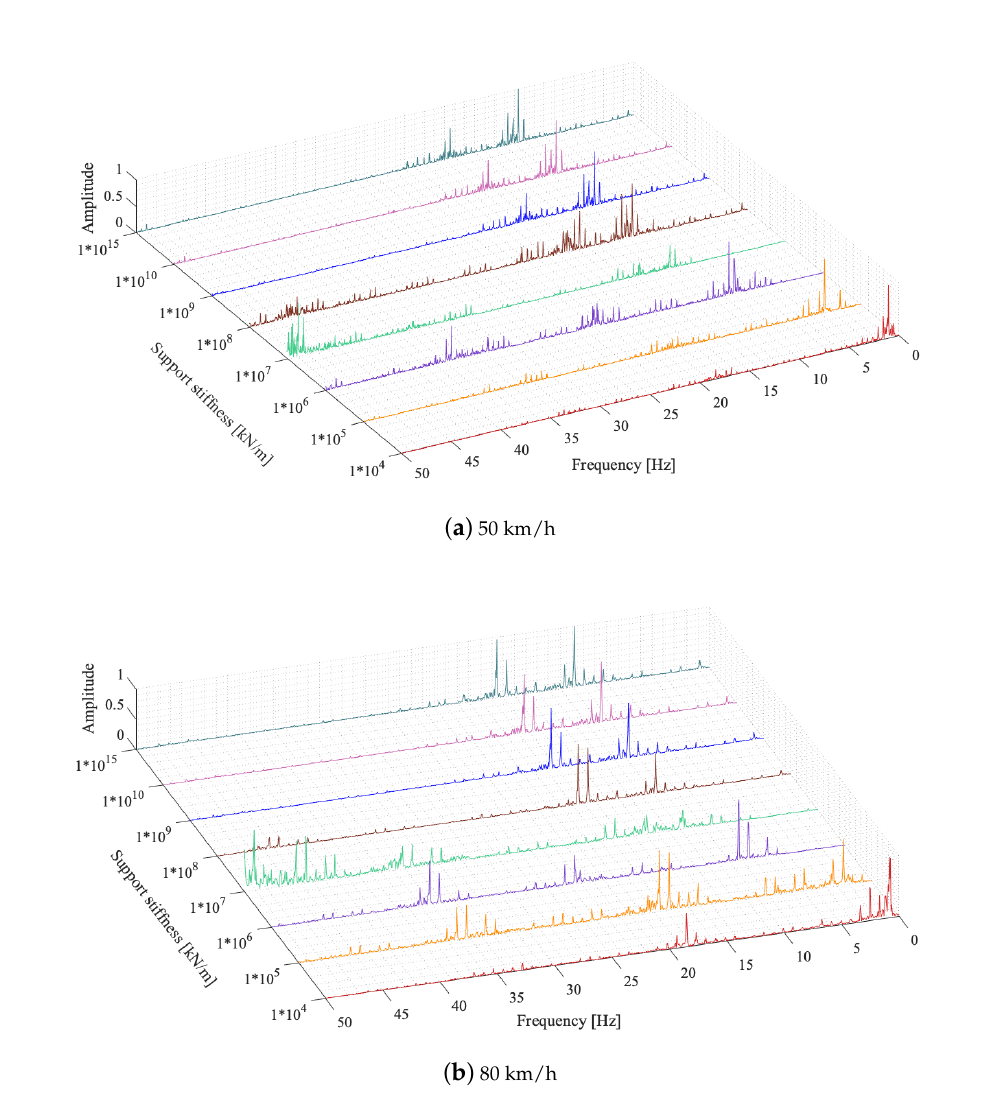
Figure 13. Fourier Amplitude Spectrum of the accelerations at the middle of the first span for the two-span bridge. Different colors correspond to different bearing stiffness values.